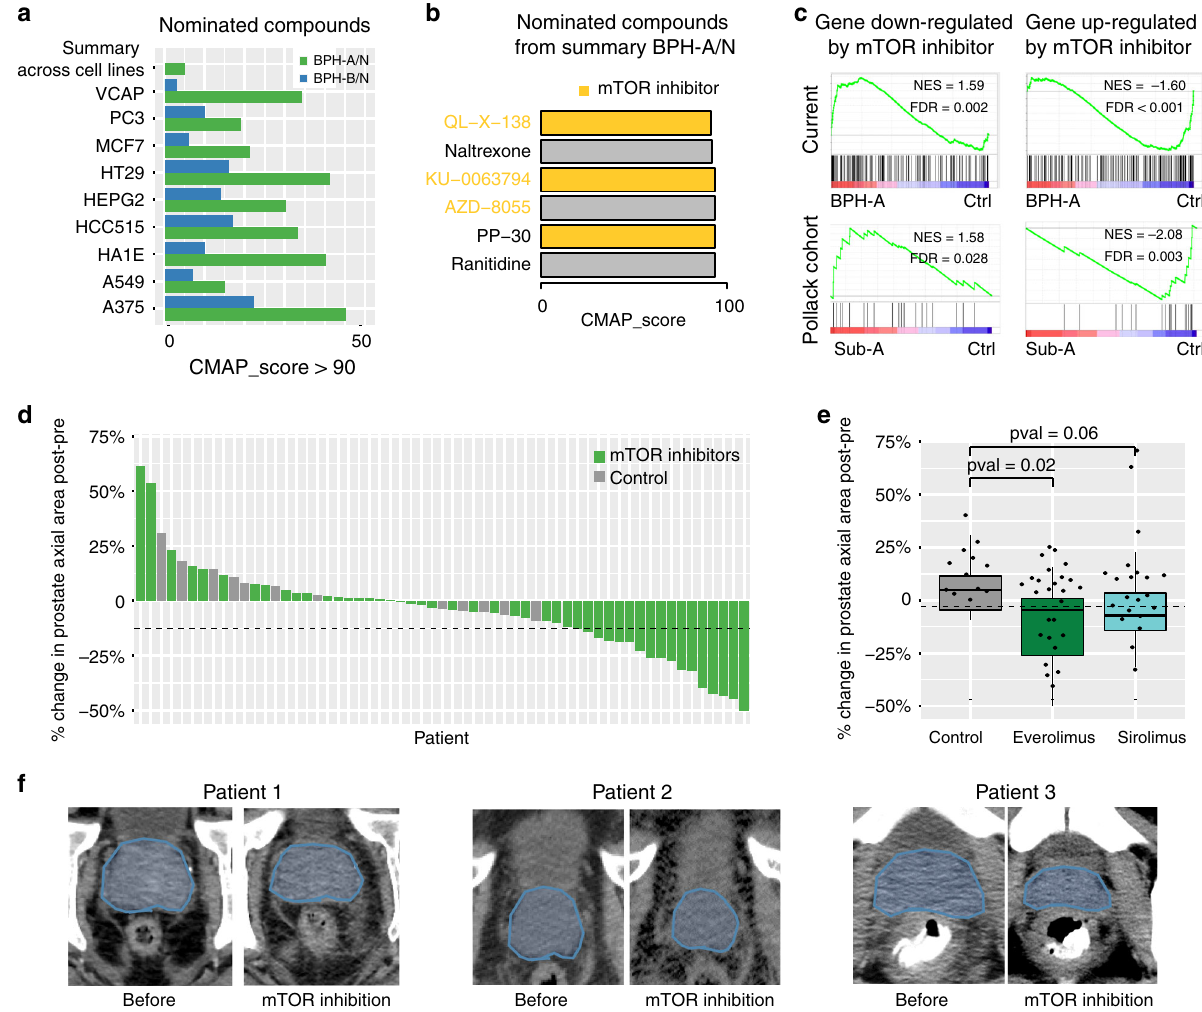
Fig. 4 BPH subgroup-speci fi c alterations and potential therapeutic options. a Barplots of nominated compounds from each BPH subgroup when comparing with control samples across multiple cell lines, and summary from all cell lines via Connectivity Map (CMAP). The x -axis denotes CMAP score. Different colors represent BPH subgroups. b Nominated compounds from subgroup BPH-A via Connectivity Map. The x -axis denotes the CMAP score. c GSEA analysis of mTOR related signatures in subgroup BPH-A and subgroup Sub-A from independent study 18 , showing that genes down-regulated by mTOR inhibitor are positively enriched, and genes up-regulated in CEM-C1 cells (T-CLL) by mTOR inhibitor are negatively enriched, compared to control samples. d Waterfall plot of % prostate axial area change on computed tomography in 47 patients after initiating therapy with an mTOR inhibitor and 12 kidney stone patients (negative controls). Different colors represent patient type. Dashed line represents a predetermined threshold (12.5%) for a signi fi cant decrease in area. e Boxplots of % prostate area change in 47 patients taking mTOR inhibitors (26 with Everolimus and 21 with Sirolimus treatments), and 12 negative controls. P -values represent prostate size change for each drug as compared to controls via using two-sided Wilcoxon signed- rank test. The center line represents median value, box limits represent 25% and 75% quantiles, and the top and bottom lines represent minimal and maximal values, respectively. f Examples of CT scans from three patients who had a decrease in prostate size after initiation of an mTOR inhibitor. Prostate highlighted in